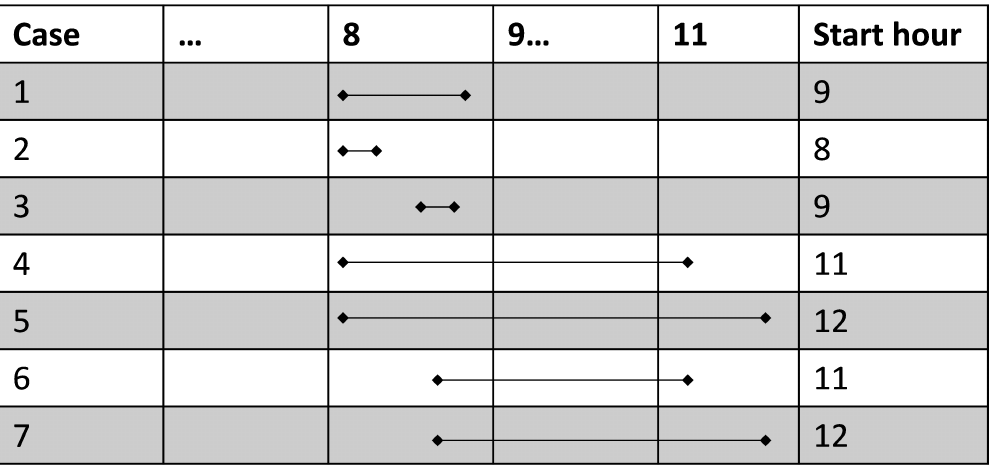
Figure A2. Differentiation of cases for the allocation of location purposes based on the trip